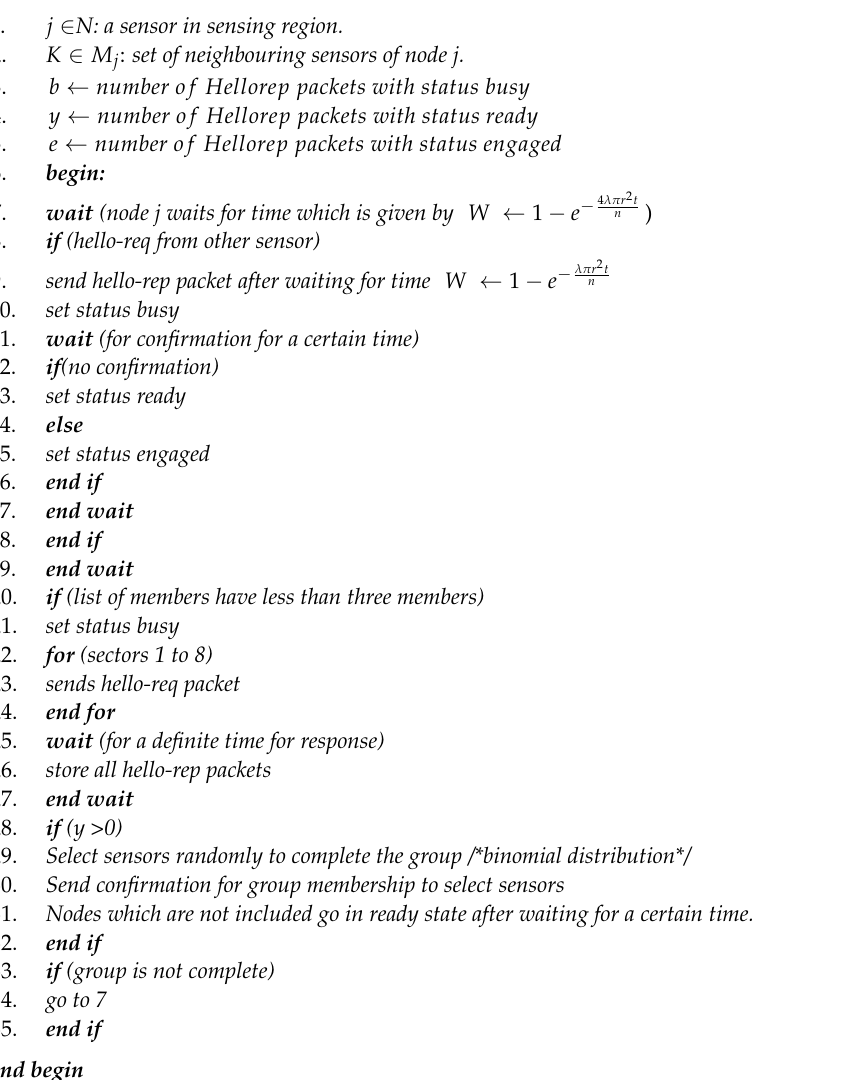
Algorithm 1: Fast Converging Grouping